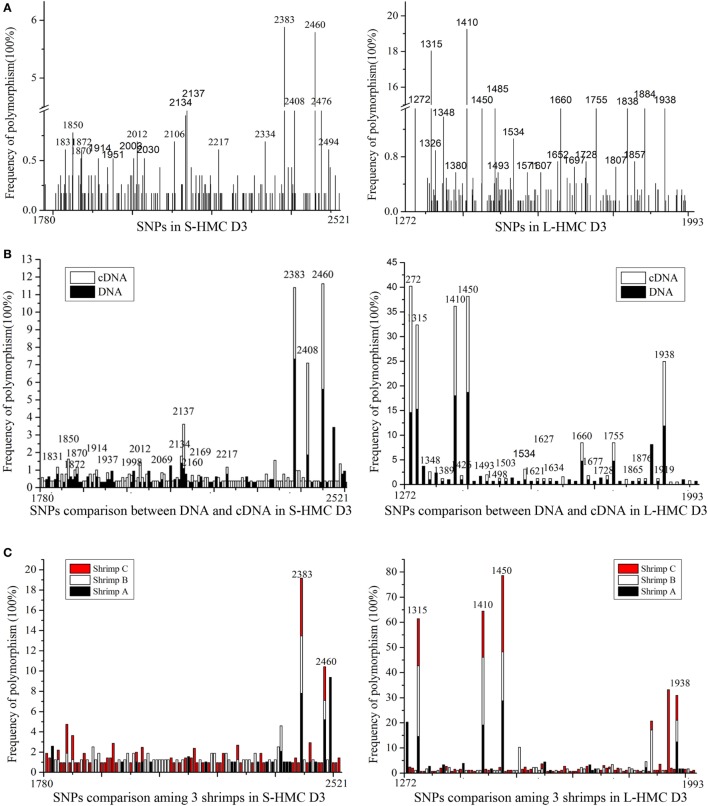
SNPs of hemocyanin (HMC) D3 domain from L. vanammei. (A) SNPs analysis of three shrimps and nauplius larvae at two levels (cDNA and genomic DNA). (B–D) Comparison of SNPs between genomic DNA and cDNA, three shrimps’ heaptopancreas, nauplius larva and three adult shrimps, respectively, based on the data of (A).